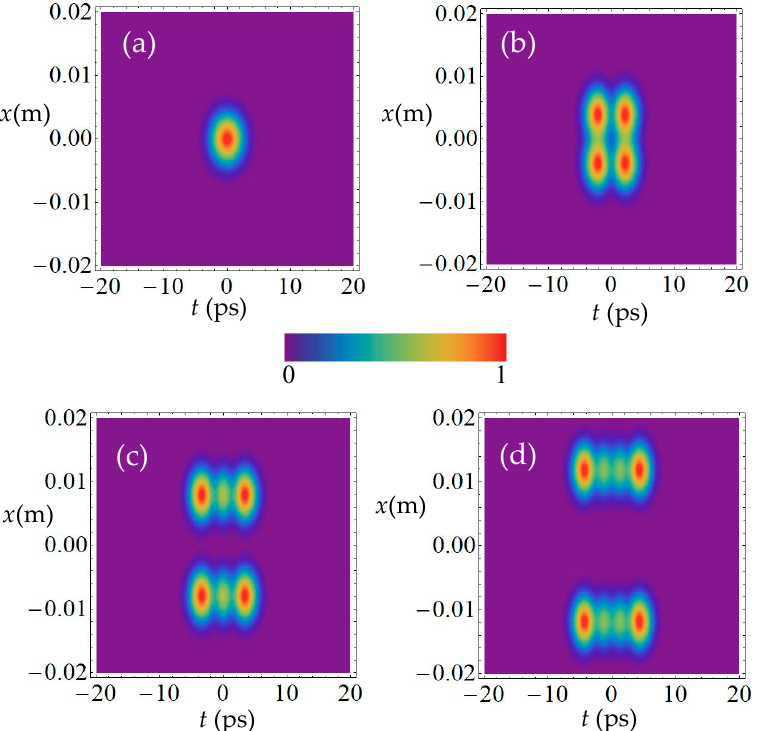
Figure 10. Density plots for the normalized spatiotemporal intensity I ( x , y , t , z ) (Equation (20)) of SCTLGSM pulsed beam in the x – t plane for different beam orders ( a ) m = n = 0, ( b ) m = n = 1, ( c ) m = n = 2, ( d ) m = n = 3 at z = 50 m with s = − 0.4ps − 2 .